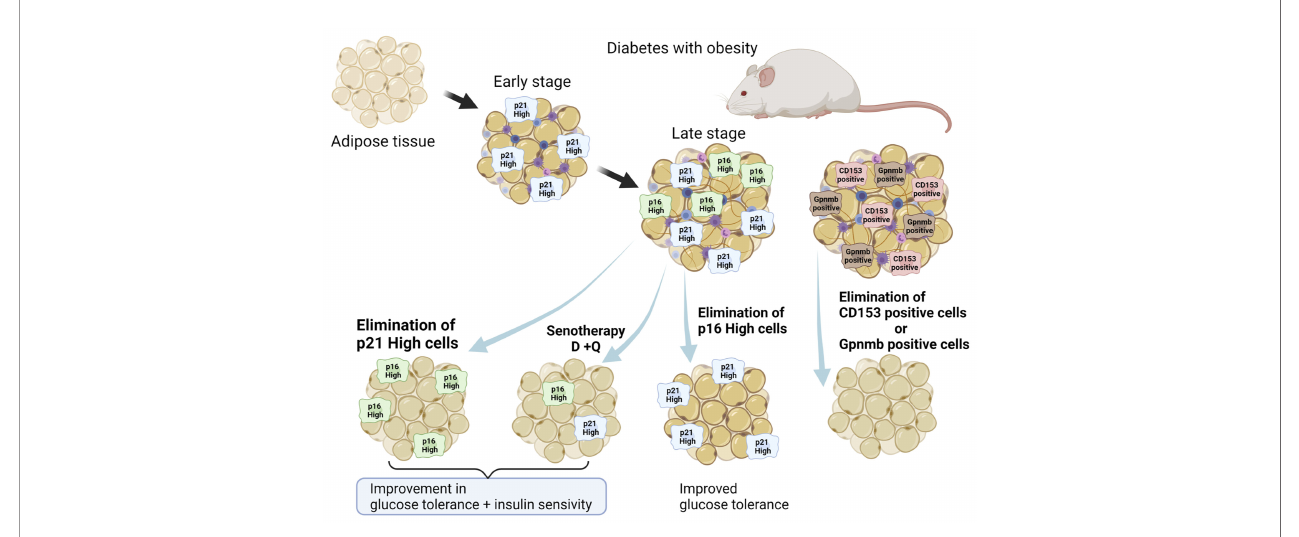
FIGURE 2 | Senolytic approach to fat senescence. Several types of senescent cells reside in WAT in obesity: p16-high cells, p21-high cells, GPNMB-high cells, and CD153 positive immune cells. Elimination of such senescent cells in WAT alleviates symptoms of diabetes with obesity. Created with